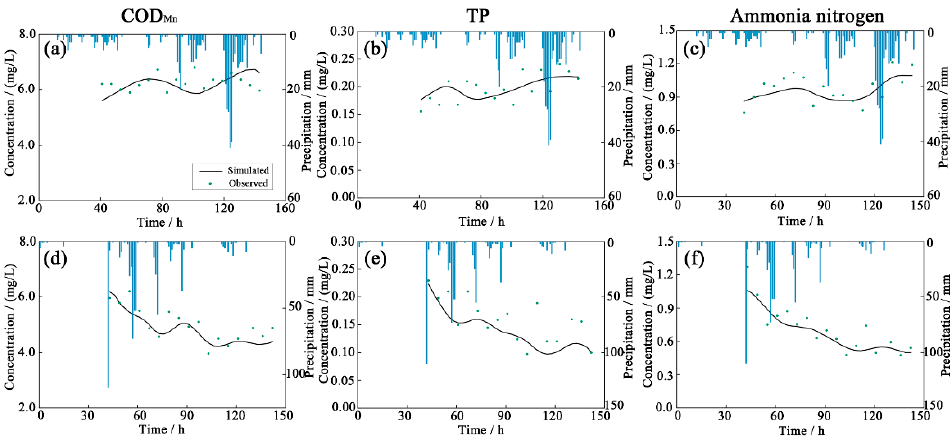
Figure 4. Calibration ( a – c ) and validation ( d – f ) results for water quality at the OUT1 drainage outlet in the SWMM model. Table 1. Hydrological and hydraulic parameters in the SWMM model of the target area. Parameter